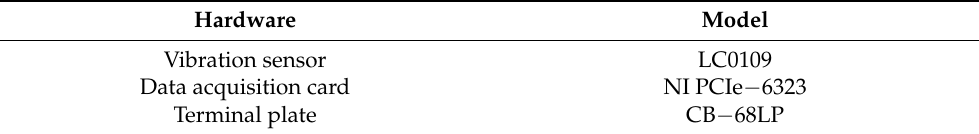
Table 7. List of vibration signal acquisition system.